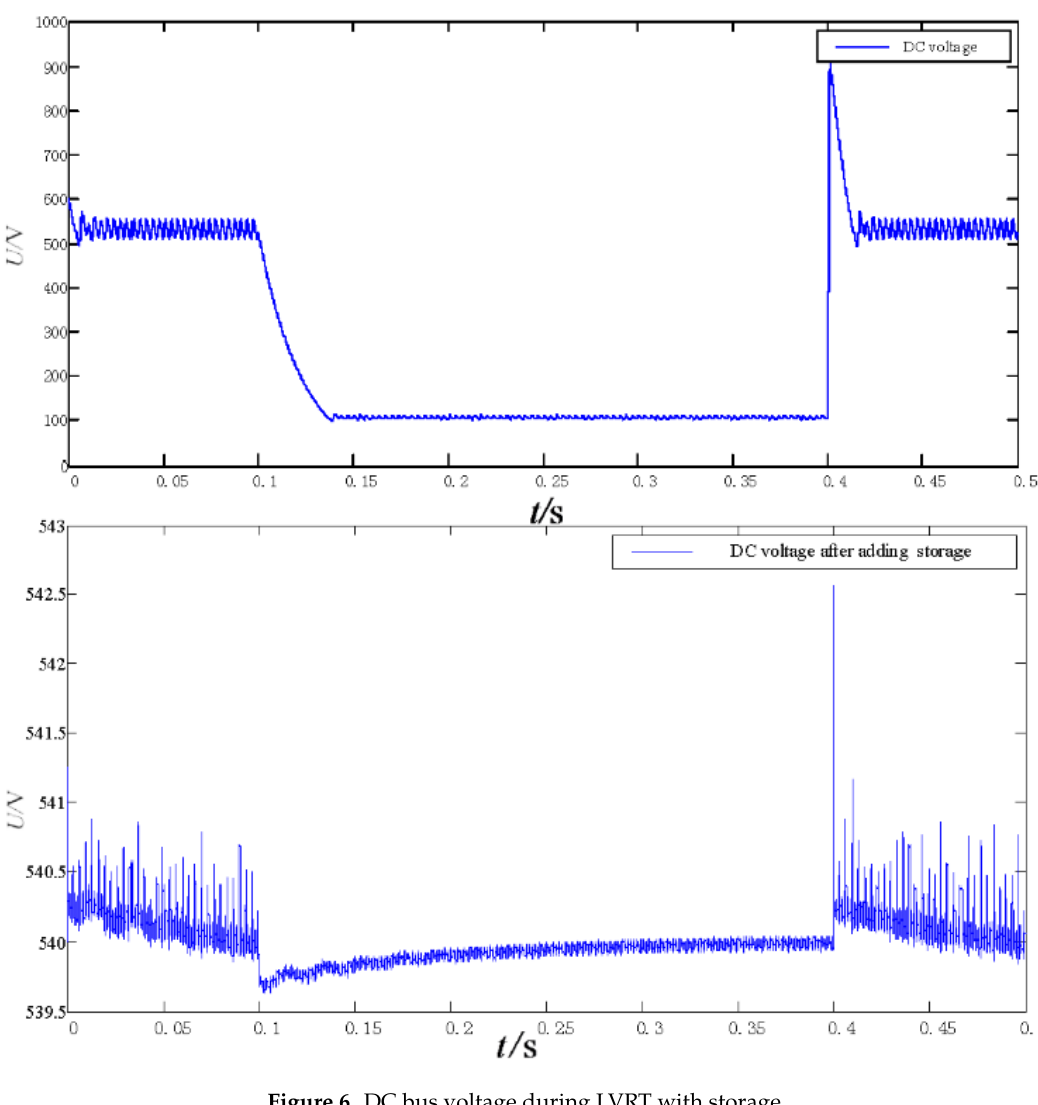
Figure 6 . DC bus voltage during LVRT with storage . Figure 6. DC bus voltage during LVRT with